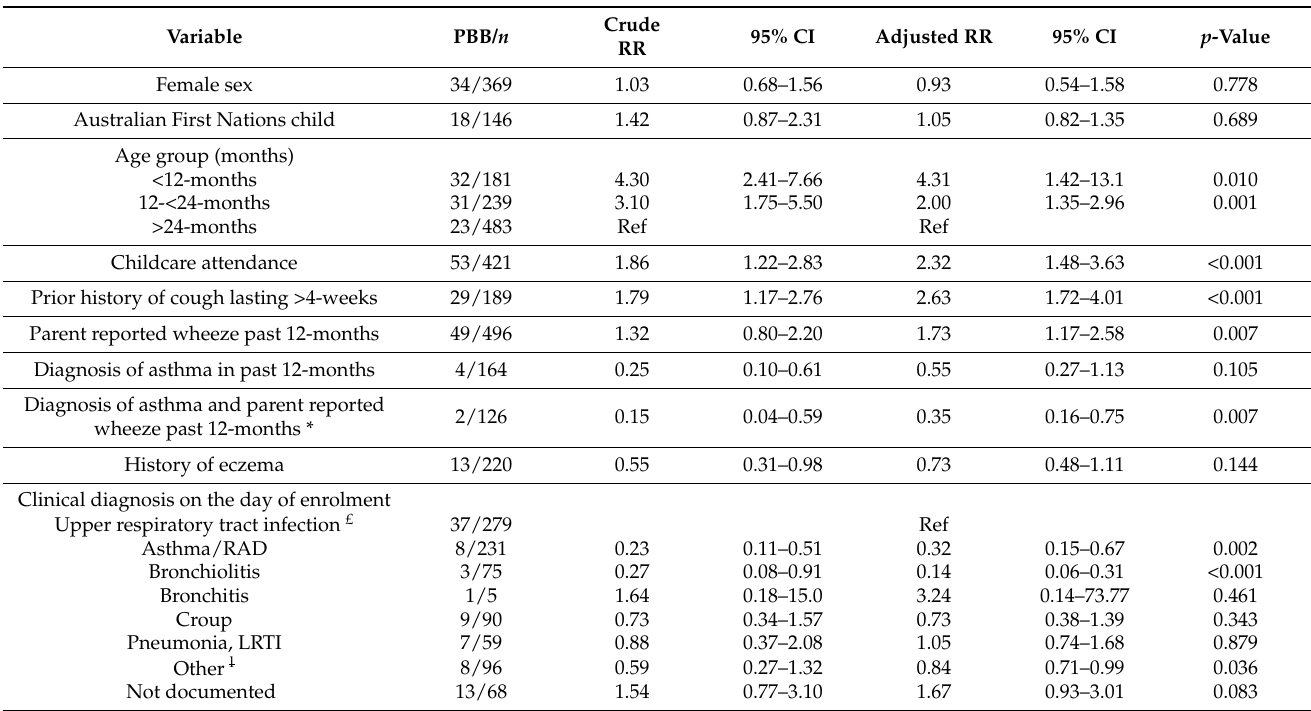
Table 2. Predictors for protracted bacterial bronchitis following an acute respiratory illness with cough in children aged <15-years, ( n = 903) t .